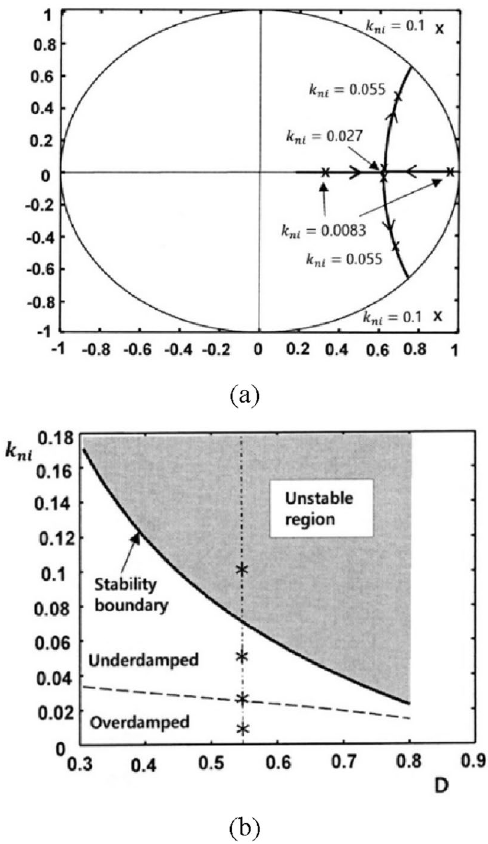
Figure 12. Experimental points: ( a ) pole locations in the z-plane and ( b ) representations in the k ni versus D plane.